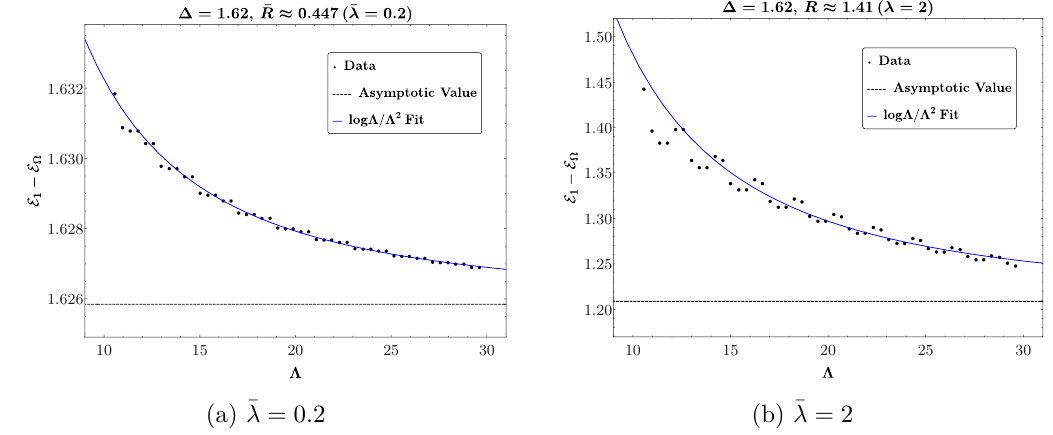
Figure 13. Hamiltonian truncation data for the energy shift of the state | χ i due to the φ 4 Hamiltonian (4.26) with ∆ = 1 . 62 , for a range of cutoffs up to Λ = 30 . The left (right) plot corresponds to quartic coupling ¯ λ = 0 . 2 ( ¯ λ = 2 ). Blue curve: fit of the form u − v ln(Λ) / Λ 2 , with the asymptotic value u shown as a horizontal dotted